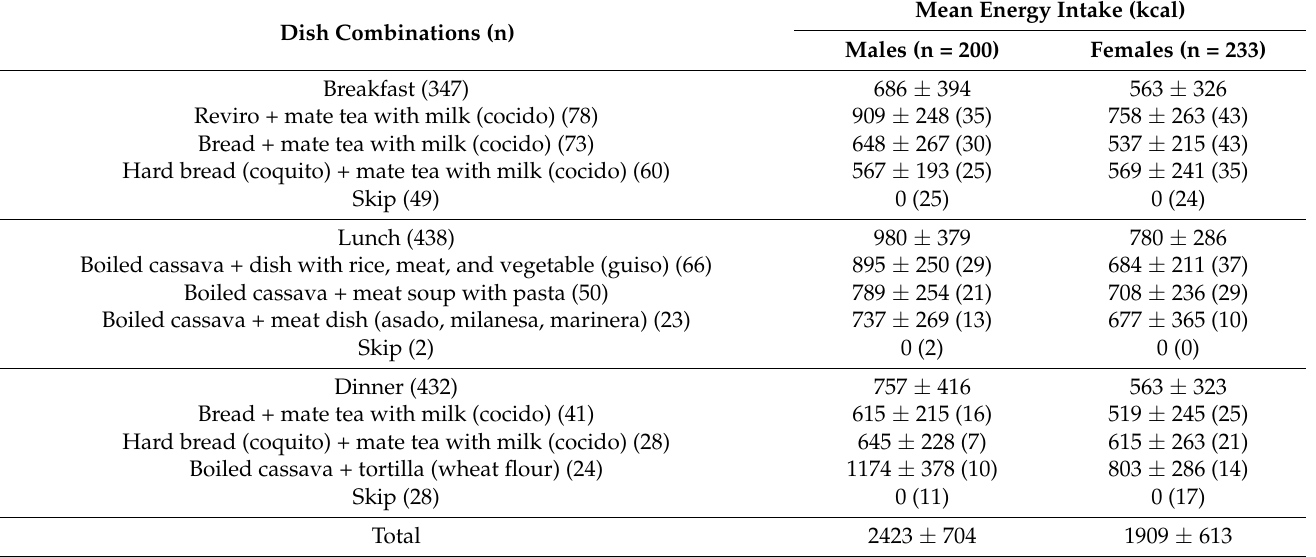
Table 6. Combinations of dishes observed frequently in